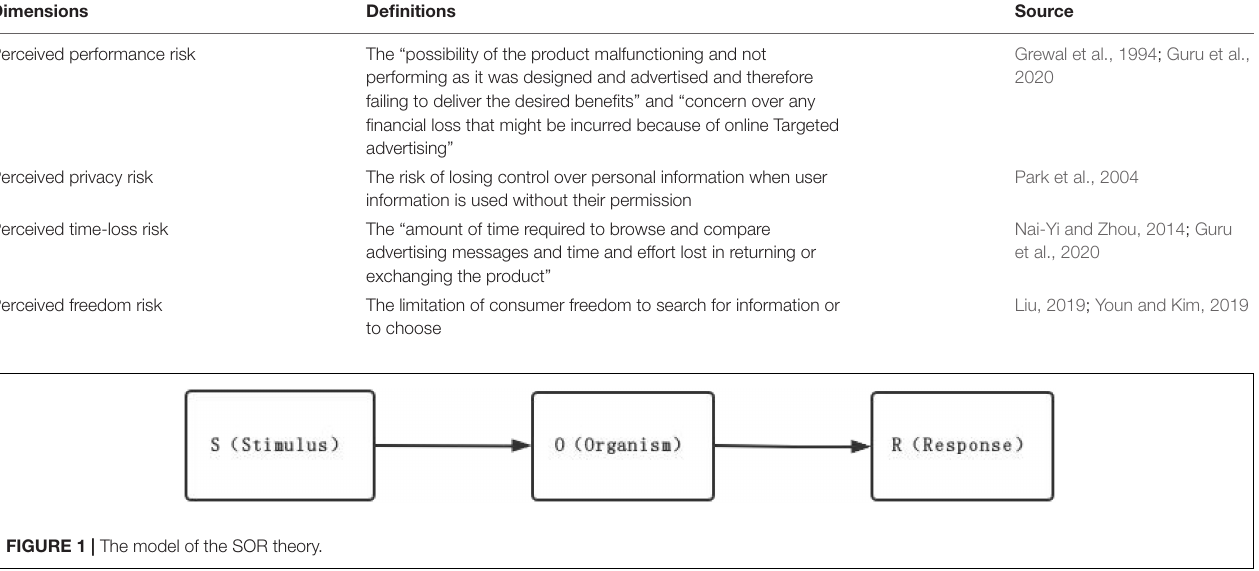
TABLE 1 | Definitions of perceived risks dimensions.